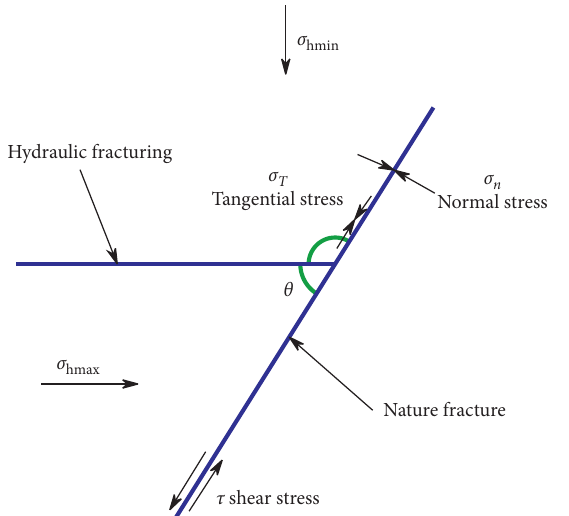
Figure 1: Schematic of a hydraulic fracture intersecting a natural fracture.